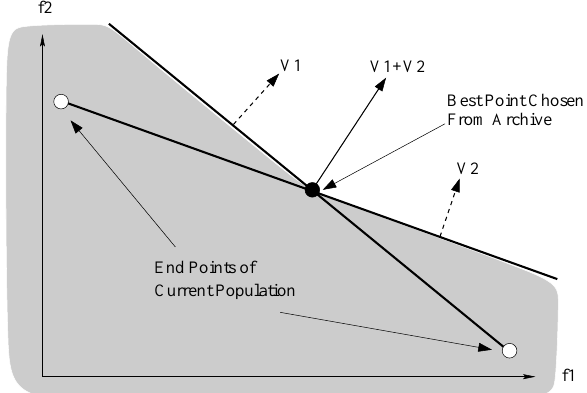
Figure 15. Polyhedral cone in 2 dimensions.